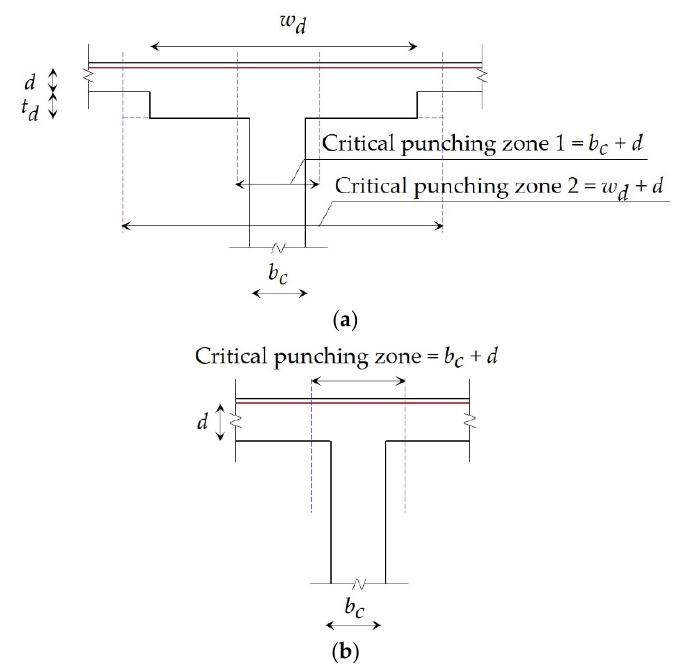
Figure 7. Critical sections of punching shear: ( a ) FSWD; ( b ) FP.